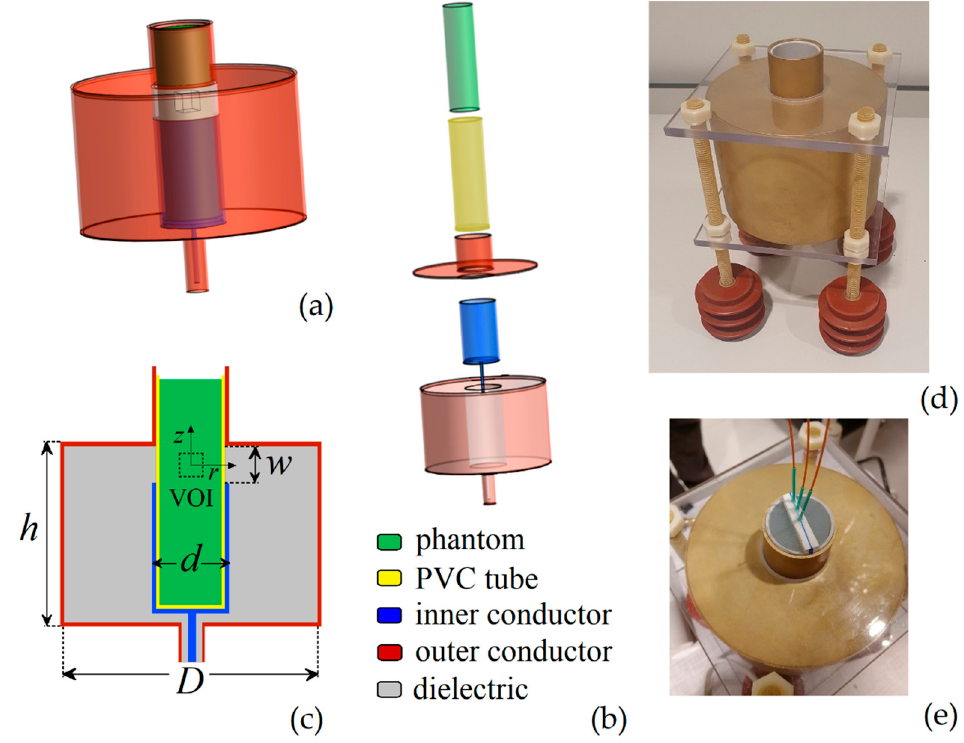
Figure 1. Schematics of the RF applicator: ( a ) 3D view with mounted components; ( b ) main components with representation of insertion; ( c ) longitudinal cross-section with indication of the main parameters, i.e., d is the outer diameter of the inner conductor, D is the inner diameter of the outer conductor, w is the aperture width and h is the external height of the outer conductor. The dashed line indicates the target region or volume of interest (VOI). Pictures of the RF applicator: ( d ) frontal view, with insulating and mechanical support; ( e ) top view showing the phantom with the fiber-optic thermometers.